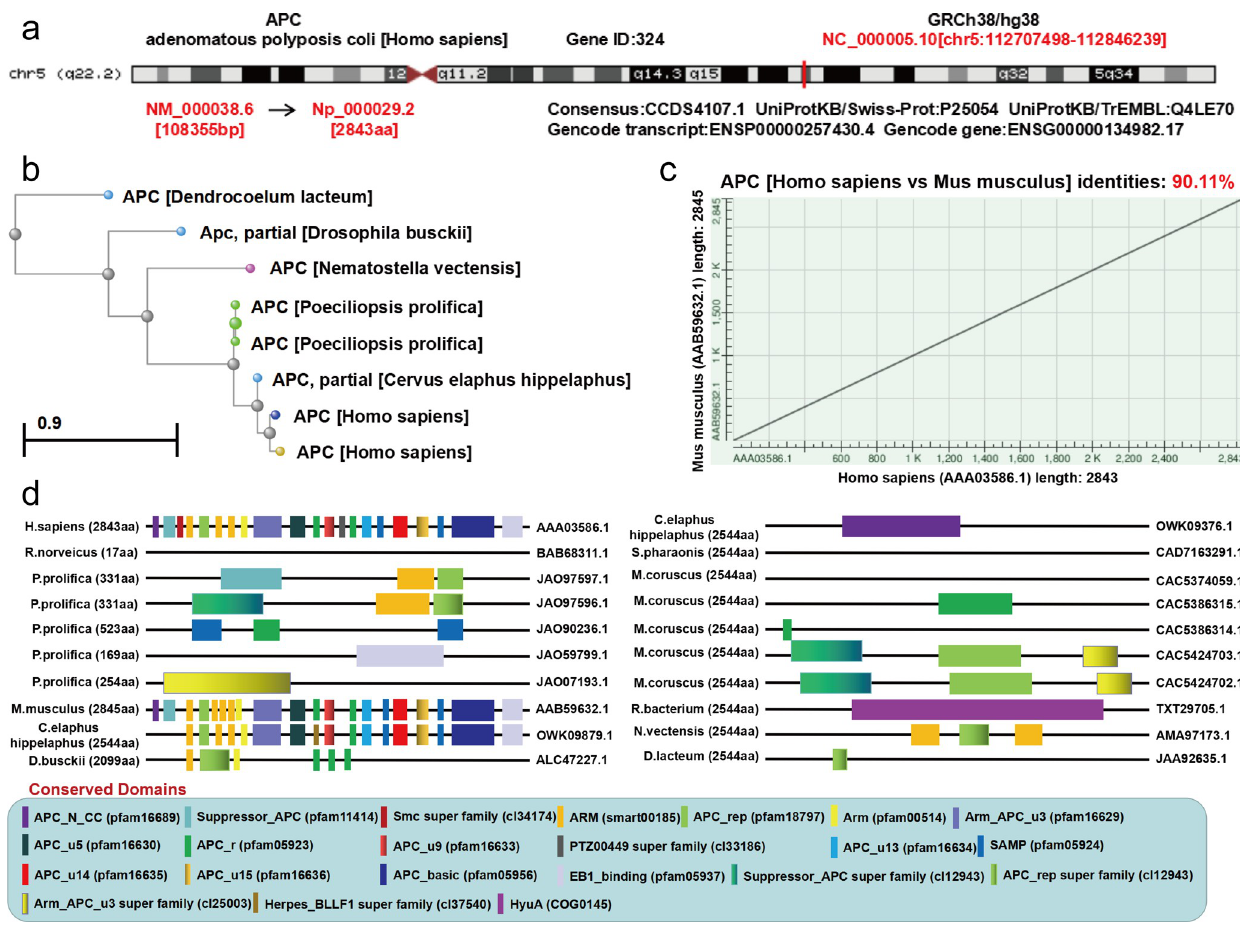
Fig 1. Gene ontology. (a) The UCSC dataset provided the genomic location of human APC . (b) The phylogenetic tree of APC . (c) Human and mouse gene similarity. (d) The “HomoloGene” function of the conserved domains of the APC protein were obtained through the NCBI.